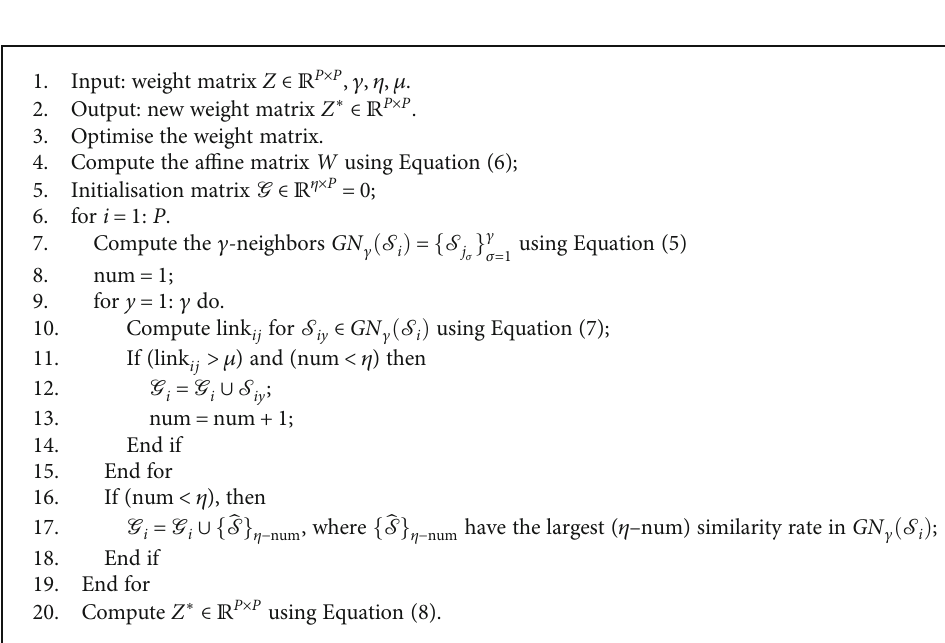
Algorithm 1: Estimation k .